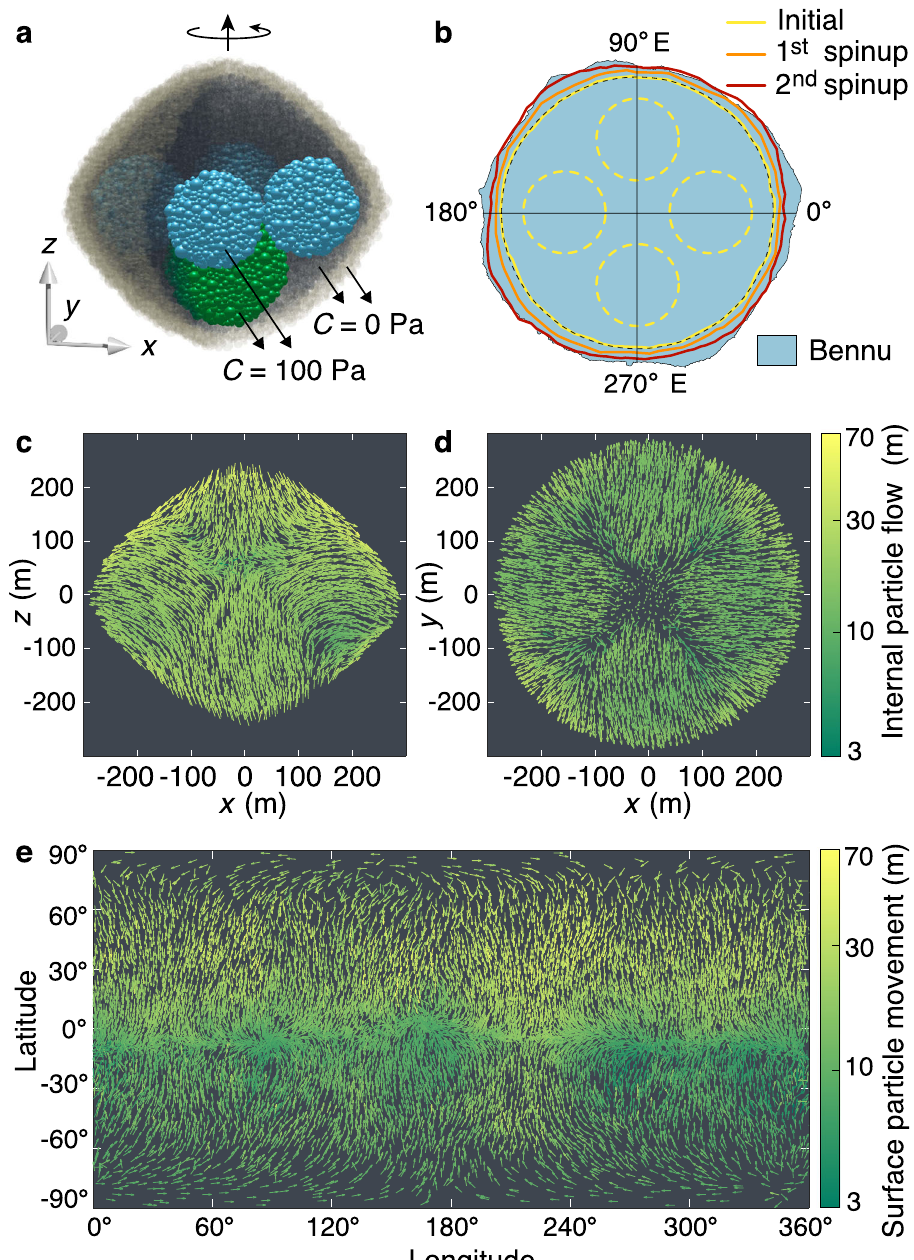
Fig. 5|Recon fi gurationandresurfacing ofa heterogeneoustop-shapedrubble pile.a Cut-awaytranslucentschematicoftheheterogeneousmodel,wheresurface particles are highlighted in beige and internal strong cohesive spherical regions ( C =100 Pa) are highlighted in blue (whose mass centres located at the equatorial plane and radii=80 m) and green (whose mass centre located at ( x , y , z )=(0,0, − 100) m and radius=100 m). The friction angle ϕ =29 ∘ . Two consecutive spinup- settling paths are applied to this model for testing its structural